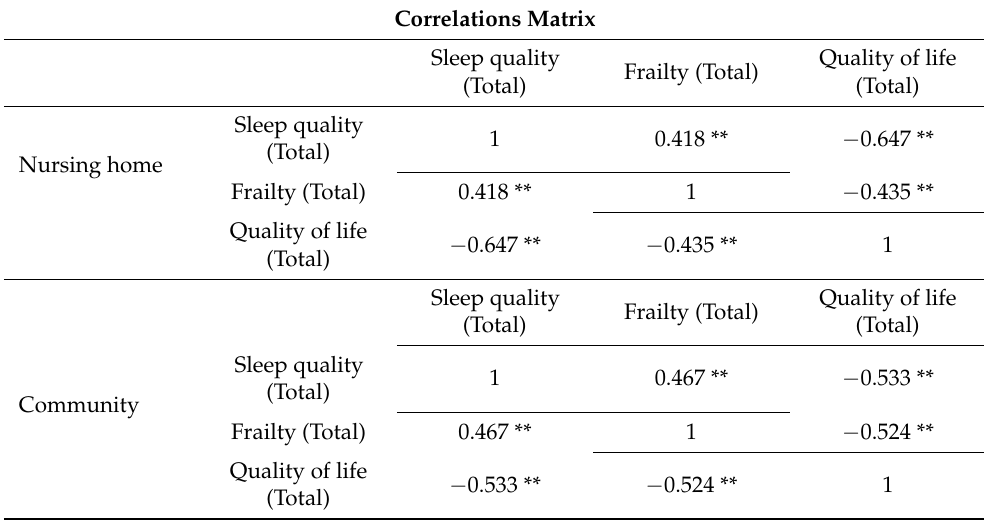
Table 2. Spearman correlations matrix of sleep quality, frailty, and quality of life between groups. Correlations Matrix Quality of life Sleep quality Frailty (Total) (Total) (Total) Sleep quality 1 0.418 ** − 0.647 ** (Total) Nursing home Frailty (Total) 0.418 ** 1 − 0.435 ** Quality of life − 0.647 ** − 0.435 ** 1 (Total) Quality of life Sleep quality Frailty (Total) (Total) (Total) Sleep quality 1 0.467 ** − 0.533 ** (Total) Community Frailty (Total) 0.467 ** − 0.524 ** Quality of life − 0.533 ** − 0.524 ** (Total)